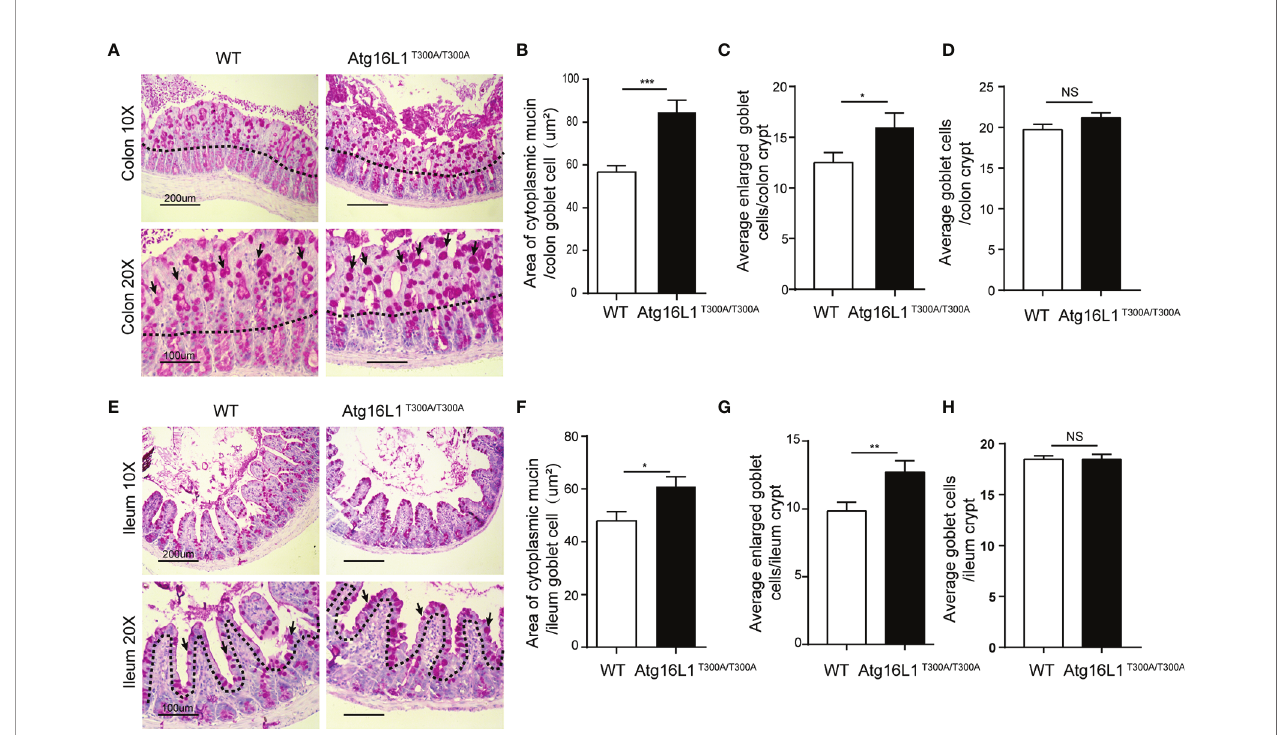
FIGURE 3 | Atg16L1 T300A/T300A mice display morphological abnormalities in their Goblet cells. (A) PAS-stained colonic sections of cohoused WT and Atg16L1 T300A/T300A mice. Hematoxylin is in blue. Black dotted lines outline the surface epithelium. Arrows indicate surface goblet cells (scale bars: down, 100 m m and upper, 200 m m). (B) Quanti fi cation of average mucin area/colon goblet cells, and (C) average number of enlarged goblet cells in the upper crypt region of cohoused WT and Atg16L1 T300A/T300A mouse colon. (D) Quanti fi cation of the total number of goblet cells per crypt in the colon of WT and Atg16L1 T300A/T300A mice (n = 6 – 8 mice/group from 3 independent experiments; 50 goblet cells measured/mouse). This analysis was performed on upper crypt goblet cells [above the upper dashed line in (A) ]. (E) PAS- stained ileum sections of cohoused WT and Atg16L1 T300A/T300A mice. Hematoxylin is in blue. Black dotted lines outline the surface epithelium. Arrows indicate surface goblet cells (scale bars: down, 100 m m and upper, 200 m m). (F) Quanti fi cation of the average area of cytoplasmic mucin/ileum goblet cells in the upper crypt region of WT and Atg16L1 T300A/T300A mouse ileum. (G) Quanti fi cation of the average number of enlarged goblet cells in the upper crypt region and (H) the average total number of goblet cells per crypt in the ileum of WT and Atg16L1 T300A/T300A mice (n = 6 – 8 mice/group from 3 independent experiments; 50 goblet cells measured/mouse). This analysis was performed on upper crypt goblet cells [above the upper dashed line in (F) ]. Data are expressed as mean and s.e.m. *p < 0.05, **p < 0.01, ***p < 0.001, NS, not signi fi cant (non-parametric test followed by a Mann – Whitney